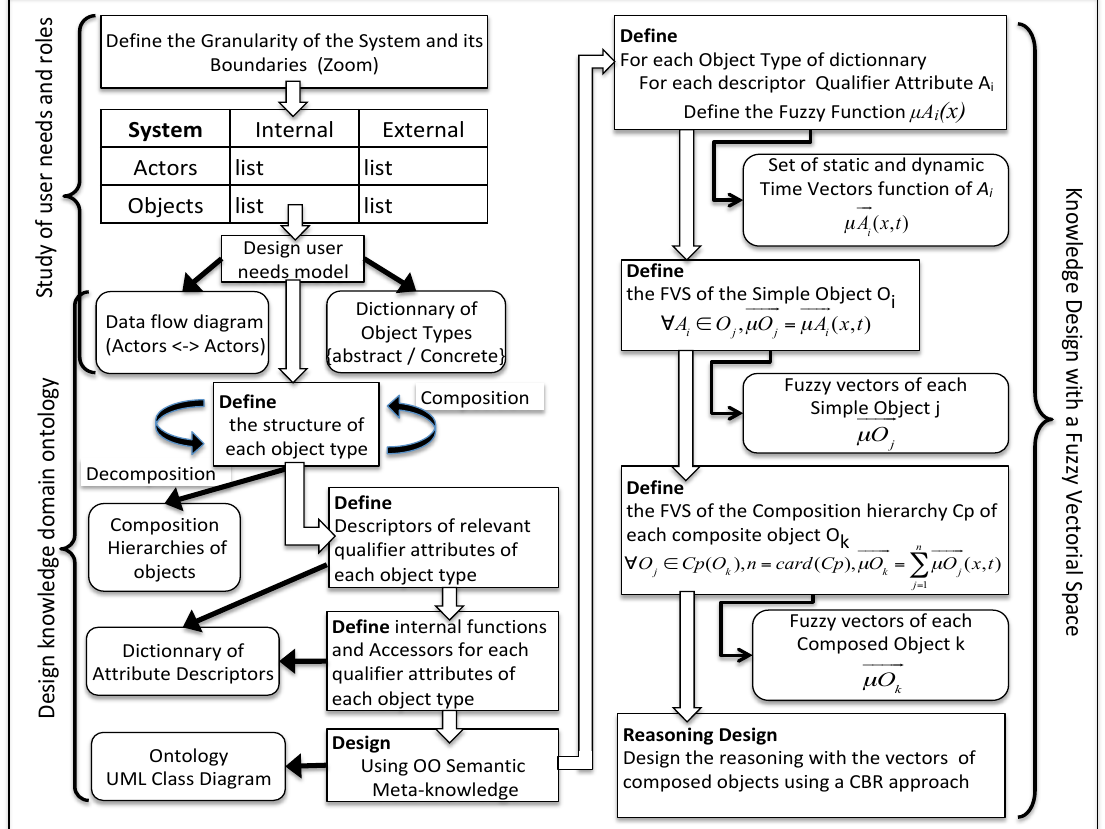
Figure 6. A method to design artificial intelligence (AI) decision support systems with fuzzy vectorial